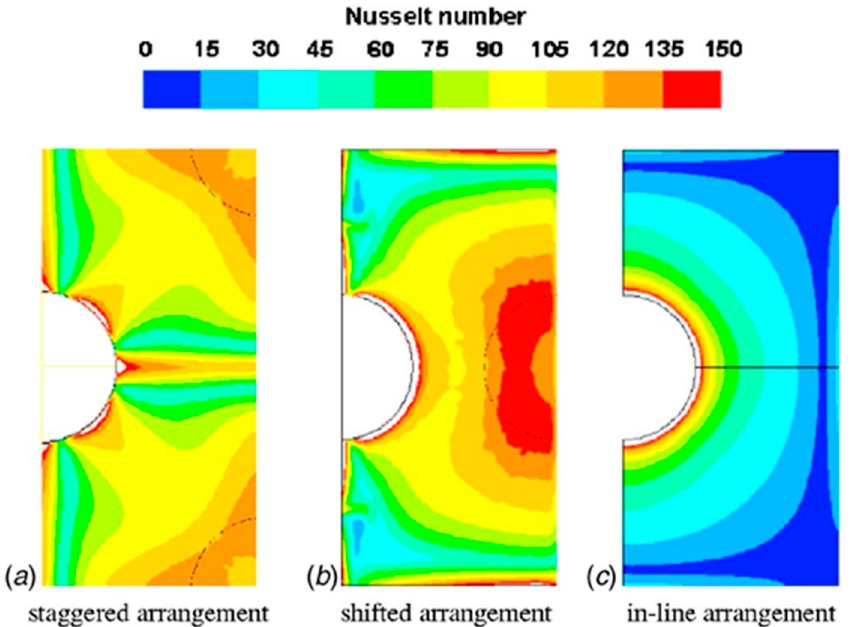
Figure 20. Nusselt number distributions for various hole arrangements. Reprinted with permission from [107]. Copyright 2008 ASME.